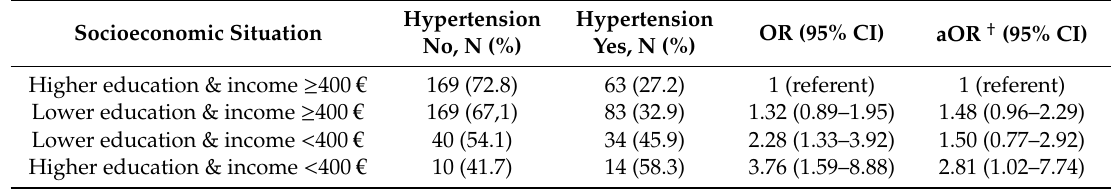
Table 4. The relationships between self-reported individual socioeconomic situation and the risk of